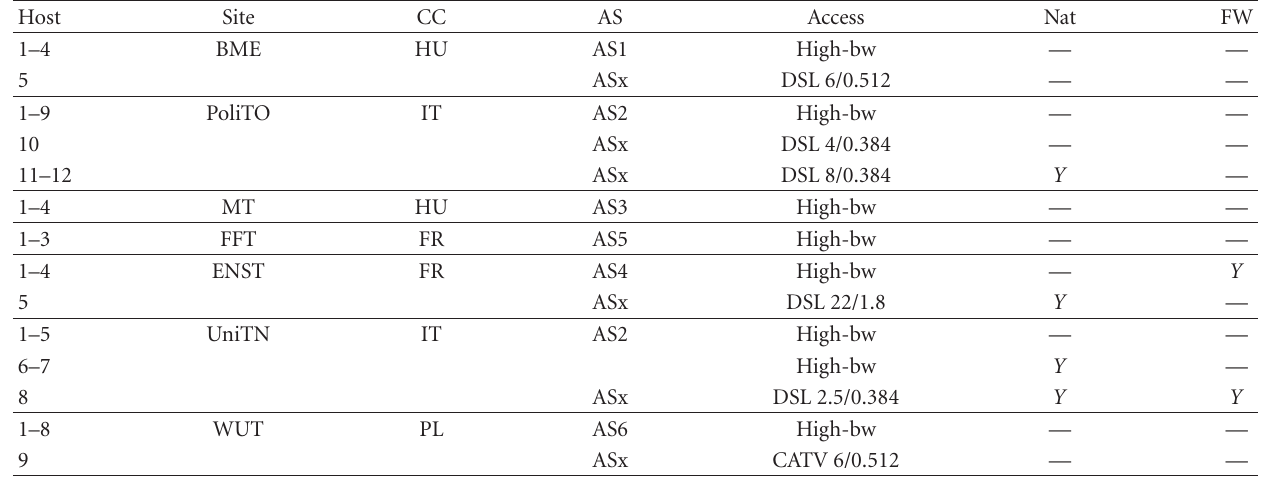
Table 1: Peerwise metrics: multiple live measurement setup. Host IDs are internal to the